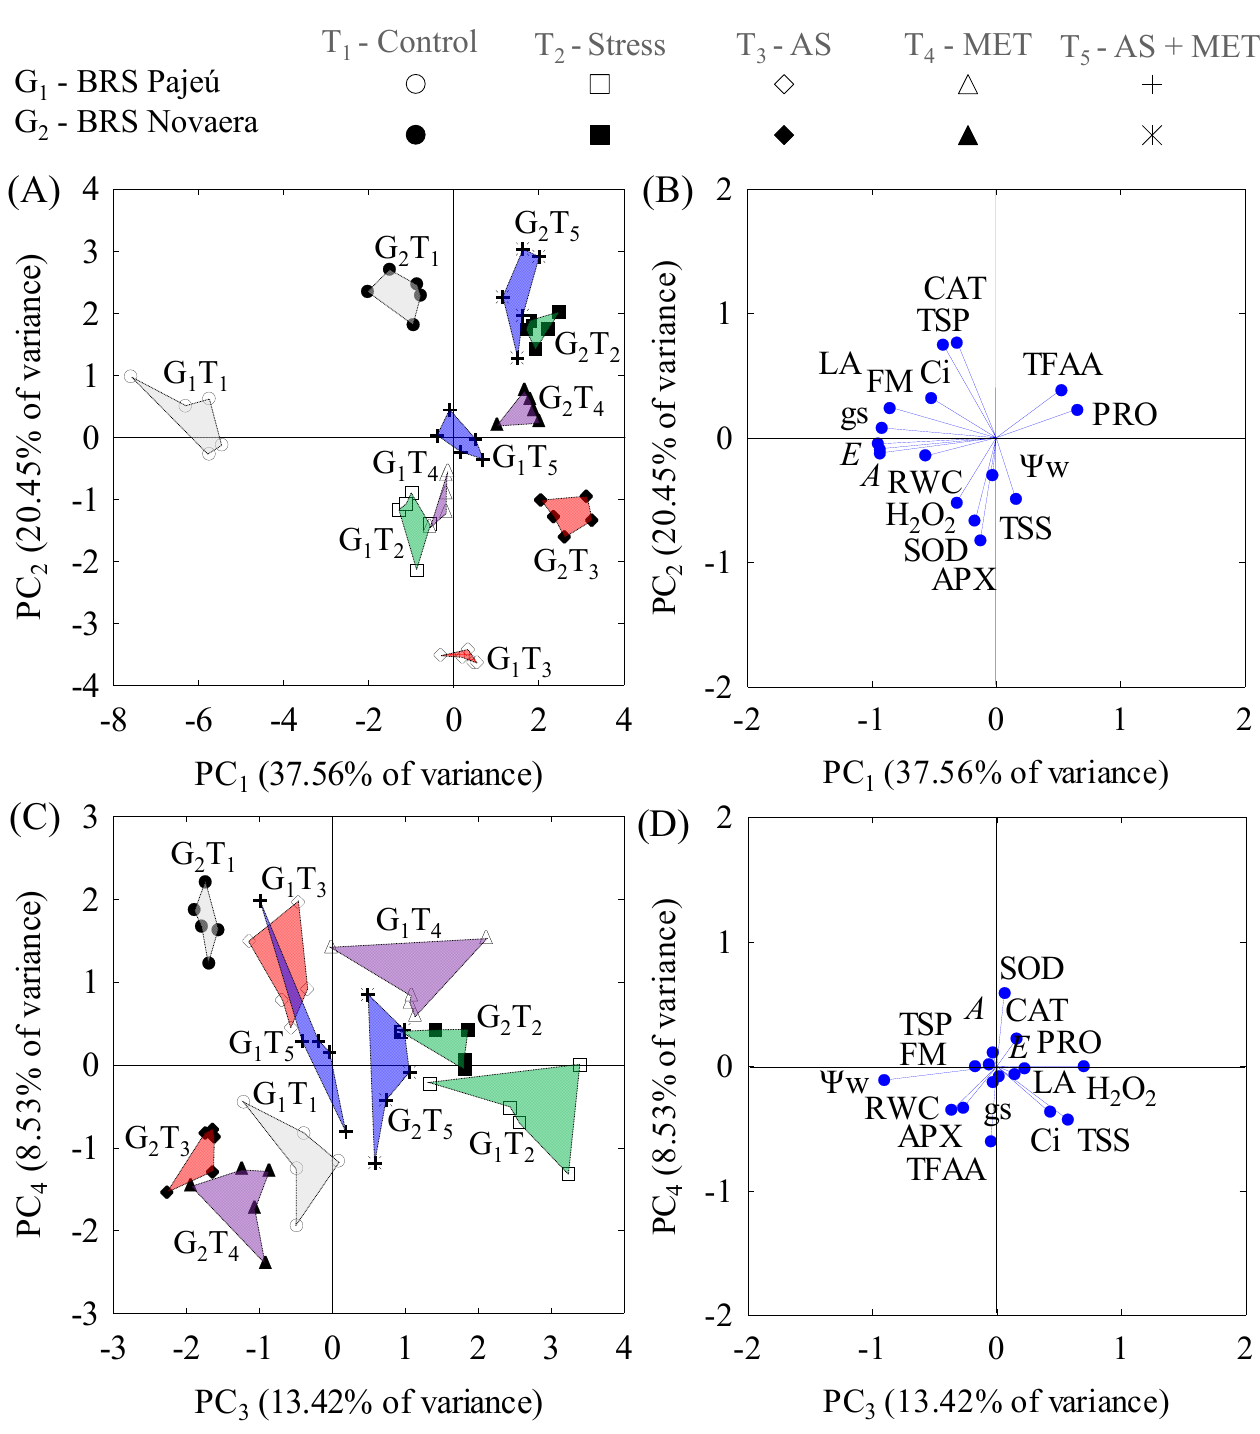
Figure 2. Two-dimensional projection of the interactions between genotypes and treatments ( A , C ) and between the correlation coefficients of the variables ( B , D ) and the first four principal components (PCs 1, 2, 3, and 4) 16 days after application of